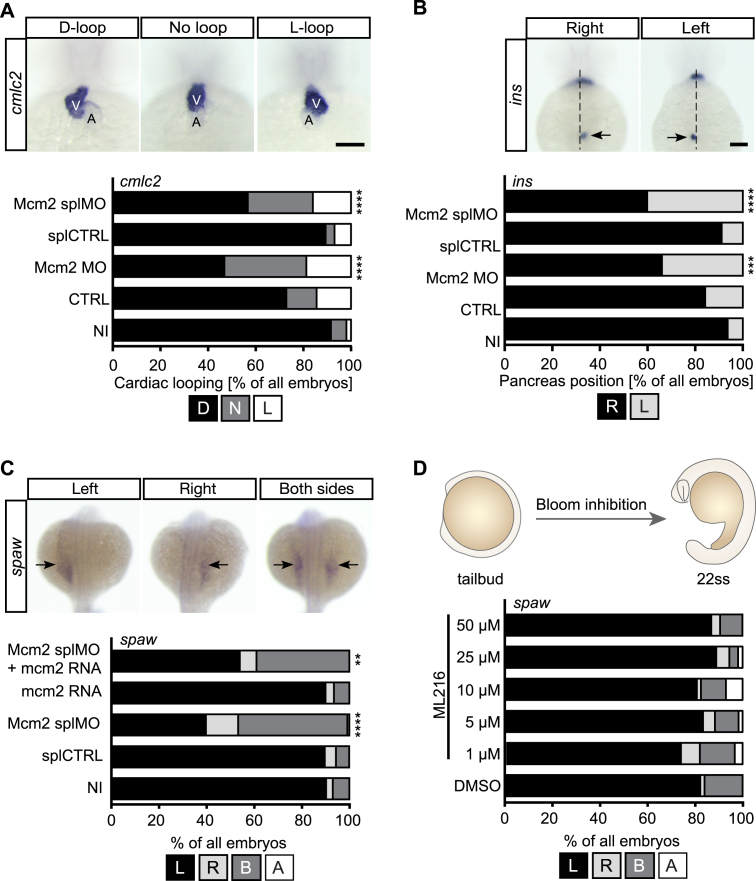
Loss of Mcm2 disrupts left-right asymmetry development. (A) Heart looping is randomized upon Mcm2 knockdown. Upper panel shows representative images of correct (D-loop) and aberrant heart looping (no loop, L-loop) at 48 hpf after in situ hybridization (ISH) for cmlc2. A, atrium; V, ventricle. Scale bar: 100 μm. Stacked bar graph summarizes heart looping experiments. D, D-loop; N, no loop; L, L-loop. P = 0.0003 (CTRL vs Mcm2 MO), P < 0.0001 (splCTRL vs Mcm2 splMO). n = 5–10 experiments. Number of embryos: NI = 309; CTRL = 166; Mcm2 MO = 128; splCTRL = 113; Mcm2 splMO = 194. (B) Example images of insulin (ins) ISH labelling of the endocrine pancreas (arrows). R, right (correct) or L, left (wrong position) of the embryonic midline. Scale bar: 100 μm.Graph displays quantification of aberrant pancreas position upon Mcm2 knockdown. P = 0.0052 (CTRL vs Mcm2 MO), P < 0.0001 (splCTRL vs Mcm2 splMO). n = 4–9 experiments. Number of embryos: NI = 299; CTRL = 146; Mcm2 MO = 109; splCTRL = 113; Mcm2 splMO = 192. (C) Loss of Mcm2 results in ambiguous southpaw (spaw) expression at 22 ss, which can be partially rescued by co-injection of mcm2 RNA. Upper panel shows examples of correct and aberrant spaw distribution. P < 0.0001 (splCTRL vs Mcm2 splMO), P = 0.0029 (splMO vs Mcm2 splMO + mcm2 RNA). n = 3 experiments. Number of embryos: NI = 156; splCTRL = 166; Mcm2 splMO = 152, mcm2 RNA = 142; Mcm2 splMO + mcm2 RNA = 181. (D) ML216-mediated inhibition of Bloom and Werner helicases from tailbud stage until 22ss does not affect asymmetry development. n = 3 experiments. Number of embryos: DMSO = 56; 1 μM ML216 = 61; 5 μM ML216 = 60; 10 μM ML216 = 57; 25 μM ML216 = 54; 50 μM ML216 = 53. All data analysed using two-tailed Fisher's exact test.